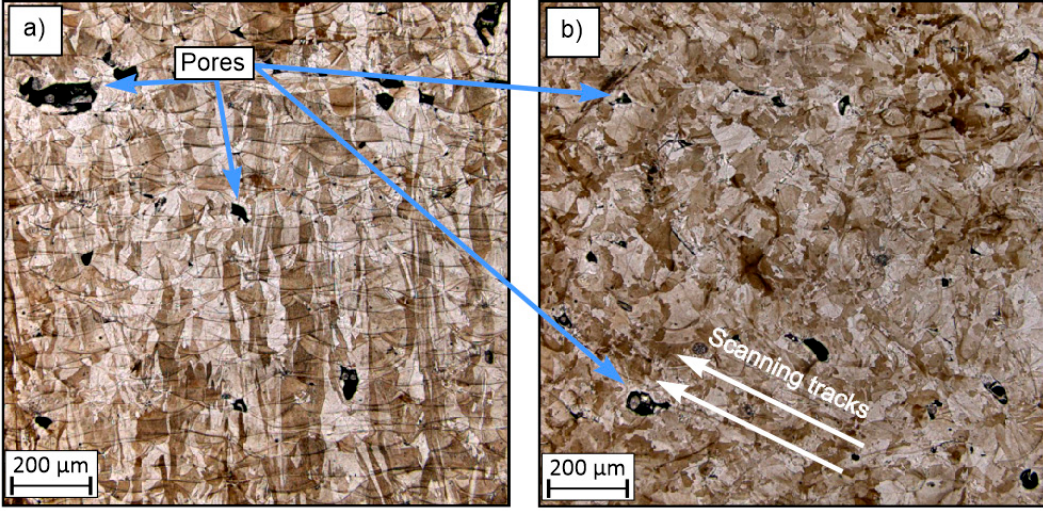
Figure 8. Microstructure of the surfaces of sample S_17: ( a ) perpendicular to the machine building platform and ( b ) parallel to the machine building platform.